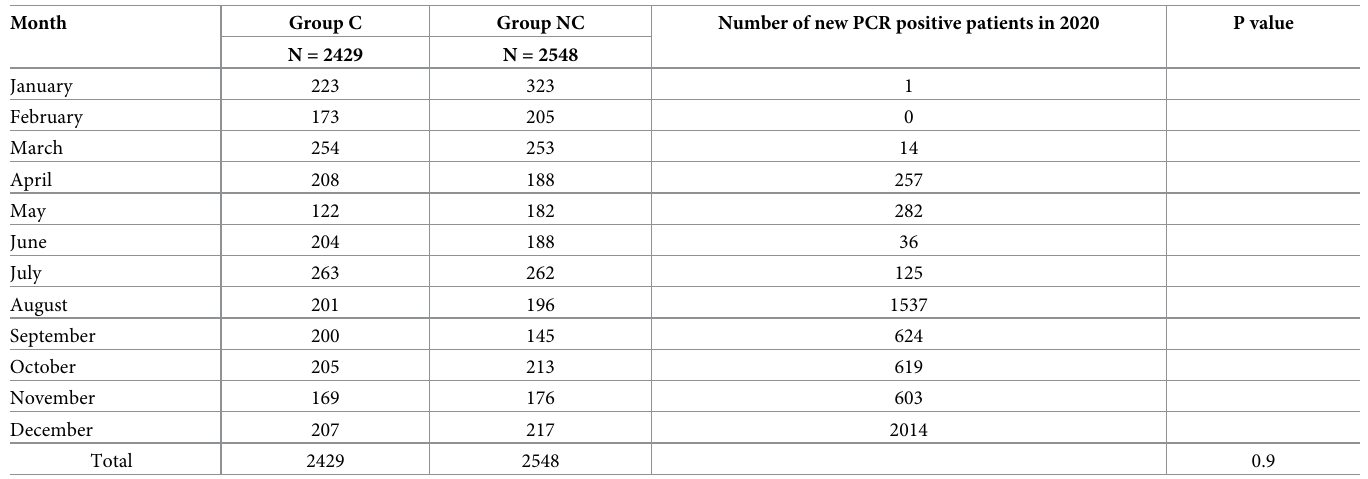
Table 3. Comparison of number of outpatients in corona era vs no corona